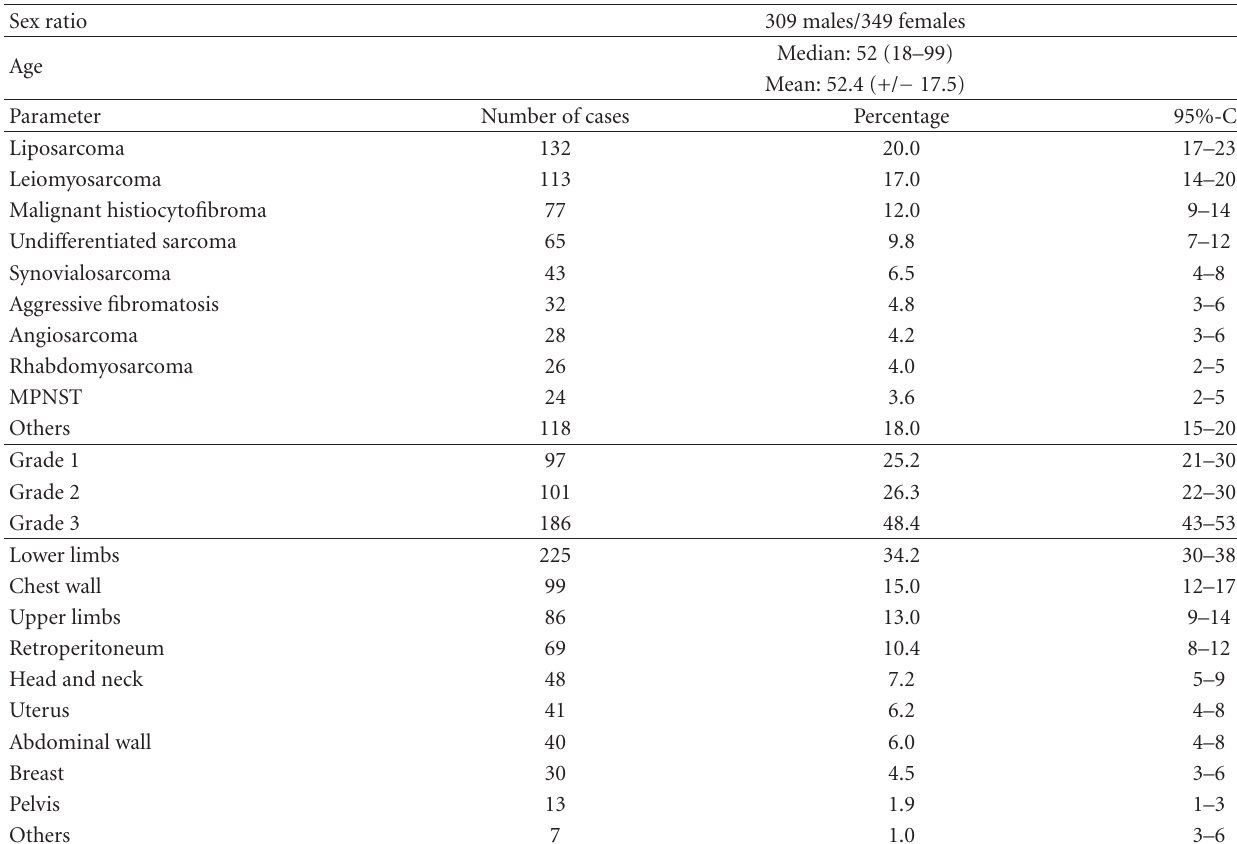
Table 1: Characteristics of 658 patients with visceral and soft tissue sarcomas treated at Oscar Lambret Cancer Centre between January 1997 and September 2005. MPNST: malignant peripheral nerve sheath